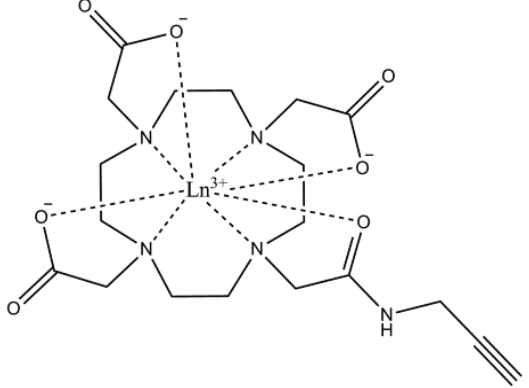
Figure 11. Chemical structure of Products 7 and 8